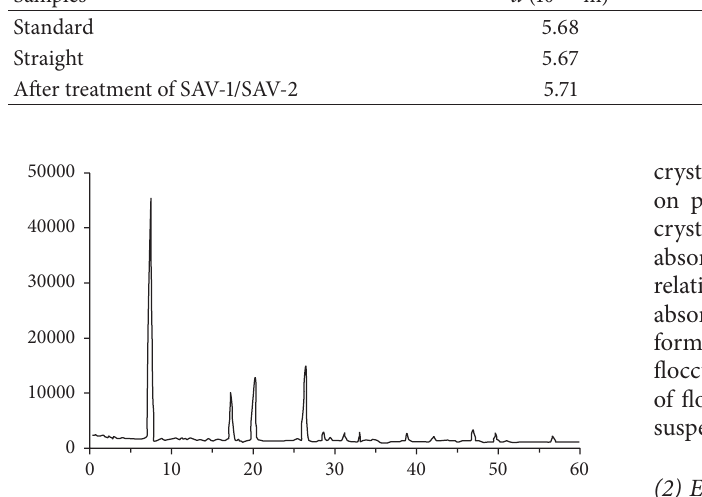
Figure 10: XRD diagram before adding SAV-1/SAV-2.